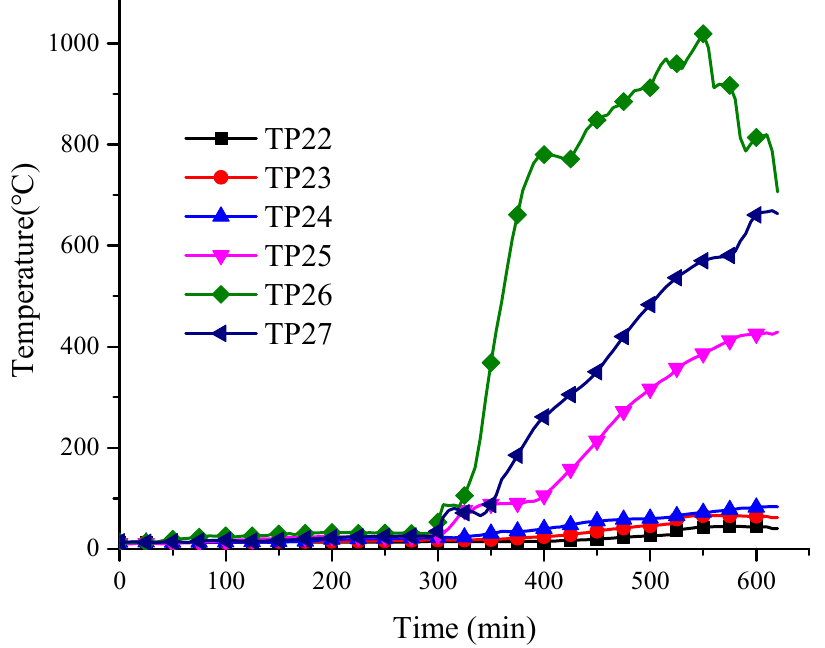
Figure 11. Temperature variation curves at different positions in horizontal direction (Path C in the middle).